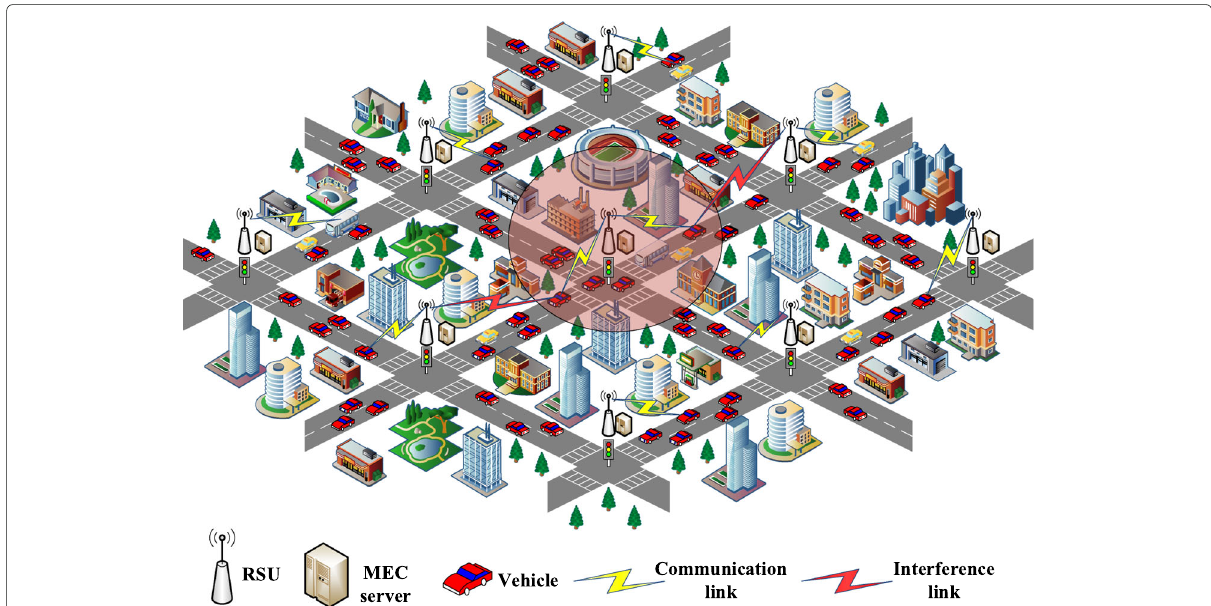
Fig. 1 Network scenario of V2I communications. Vehicles offload the task to the MEC server connected to the RSU via the V2I